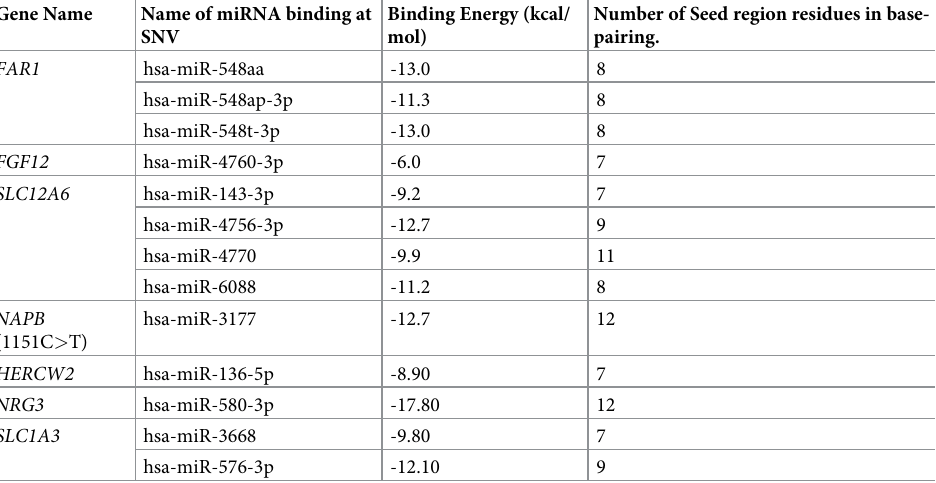
Table 4. Binding energies for binding of miRNAs at sites created by 3’-UTR